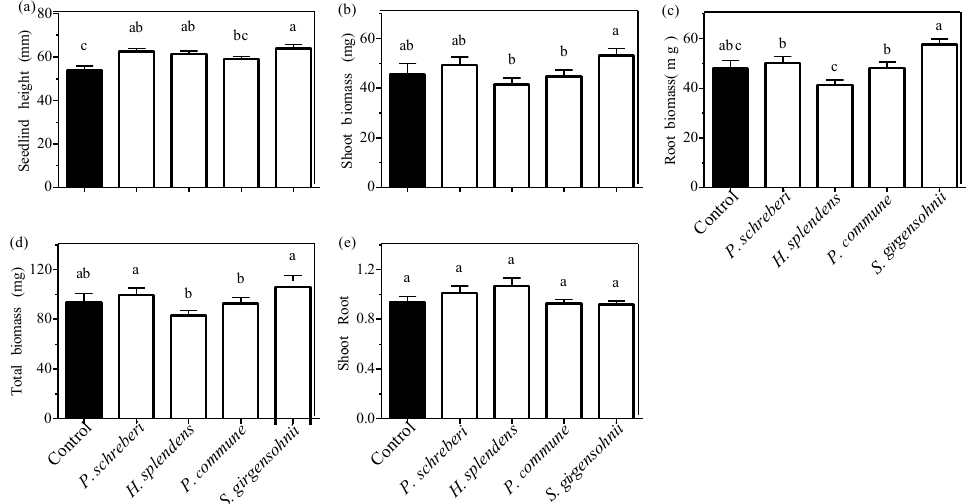
Figure 1. Response of Pinus sylvestris seedlings grown in pots containing different moss species, averaged across precipitation regimes and all moss biomass classes (MBC), including a moss-free control; bars show the means + SE. Within each subpanel, different letters above bars indicate significant pairwise differences at p < 0.05 (Tukey’s HSD); ANOVA results are presented in Table